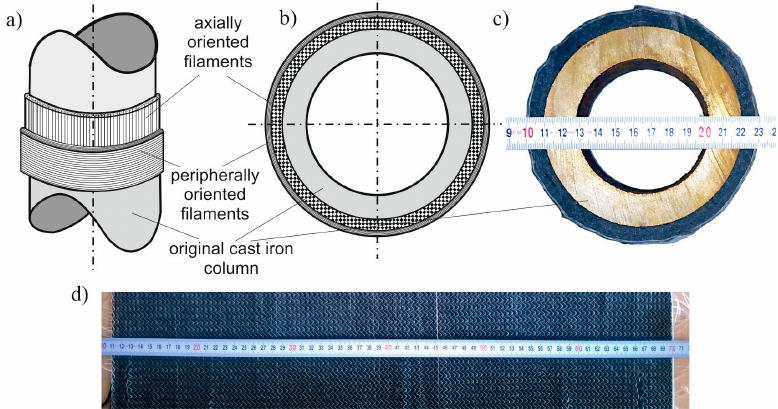
Figure 3. Details of the strengthening by the carbon fiber reinforced polymer (CFRP) fabric: ( a ) General view; ( b ) cross-section; ( c ) cross-section cut from the destroyed column; ( d ) unidirectional CFRP